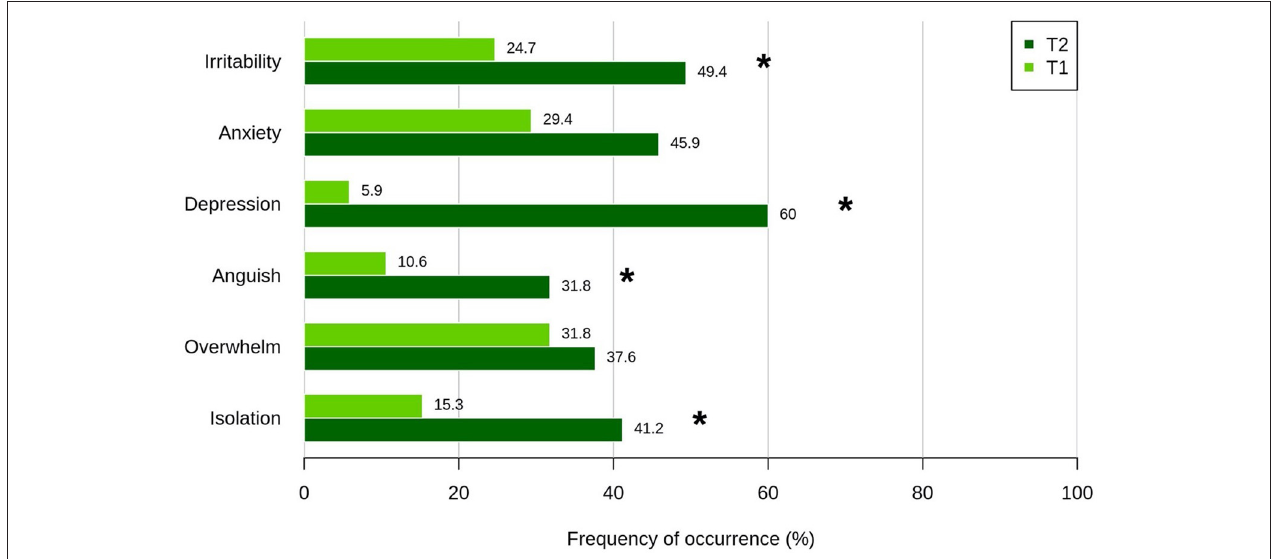
FIGURE 1 | Frequency of stress-related symptoms reported by caregivers during the first lockdown (T1, March 2020; light green) and 1 year after first restrictions (T2, March-April 2021, dark green). T1 and T2 proportion of answers were compared by means of a series of McNemar’s χ 2 tests for paired comparisons. *Bonferroni-corrected significant